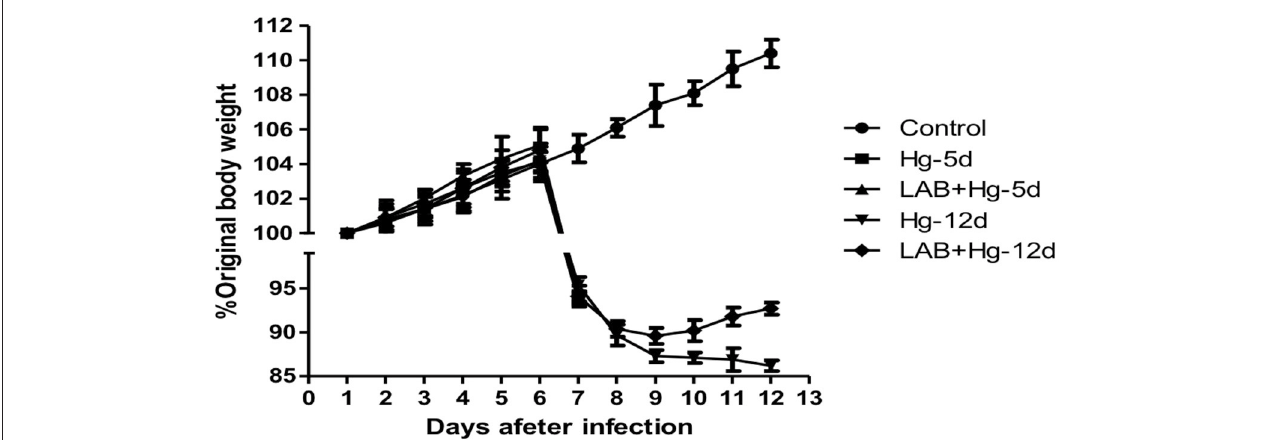
FIGURE 1 | Changes in body weight observed among the five groups of animal experiments. Original body weight is designated as 100%. After expose to mercury chloride, results show that body weight in all groups was decreased relative to